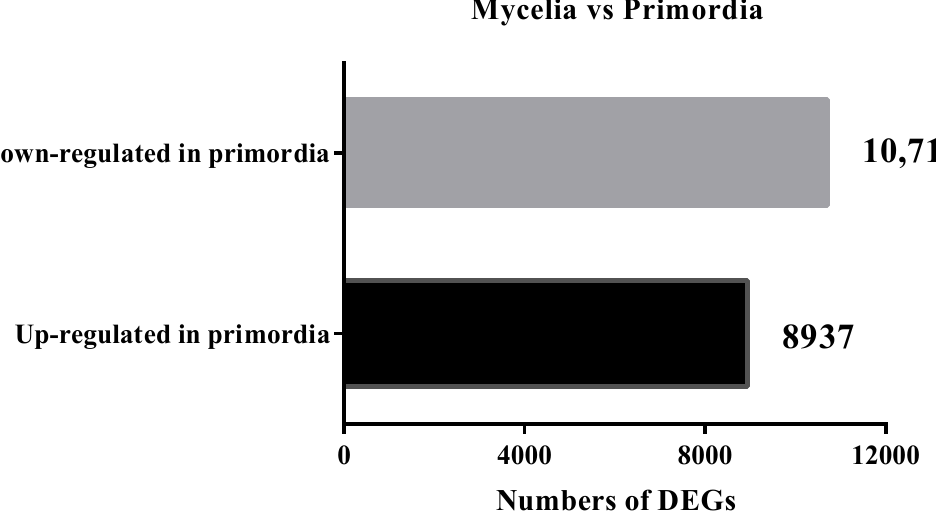
Figure 2. The number of differentially expressed genes during the transformation from mycelia to primordium.